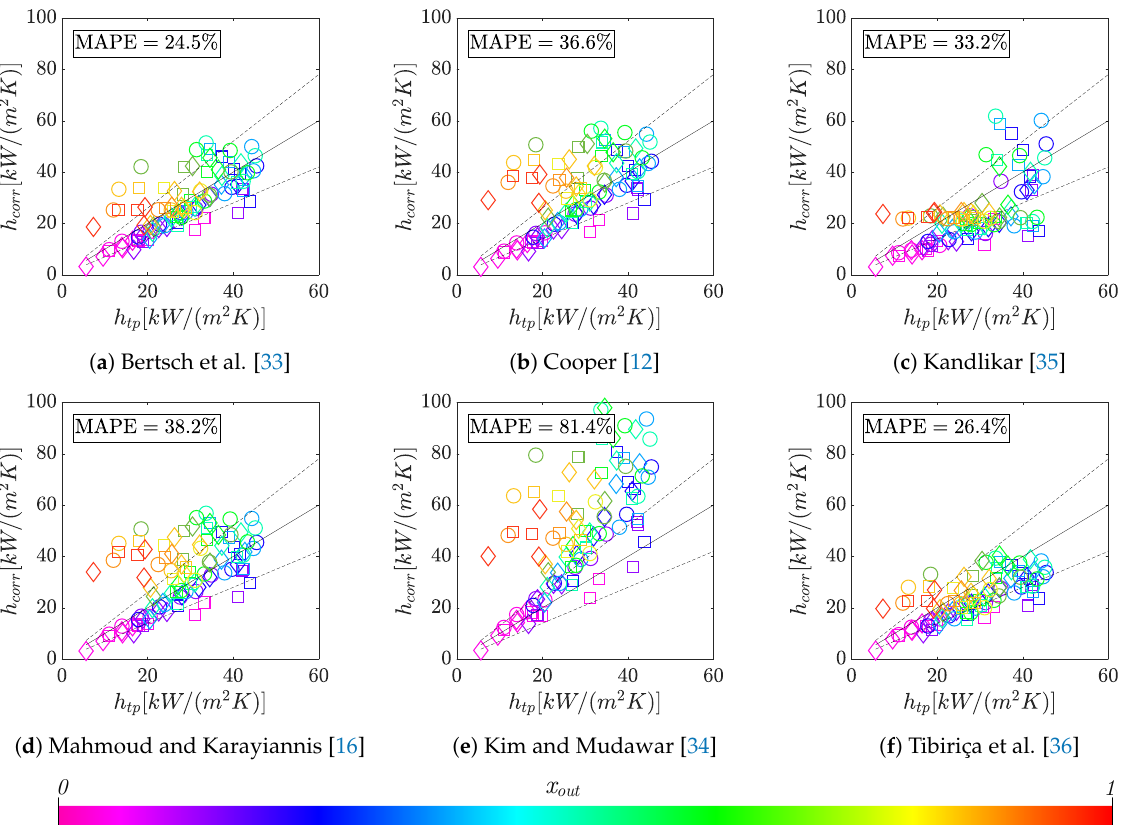
Figure 13. Comparison of experimental results with the predictions by selected correlations, with 30% error bands indicated by the dotted lines. Colors scaled with the outlet vapor quality. Geometry A =